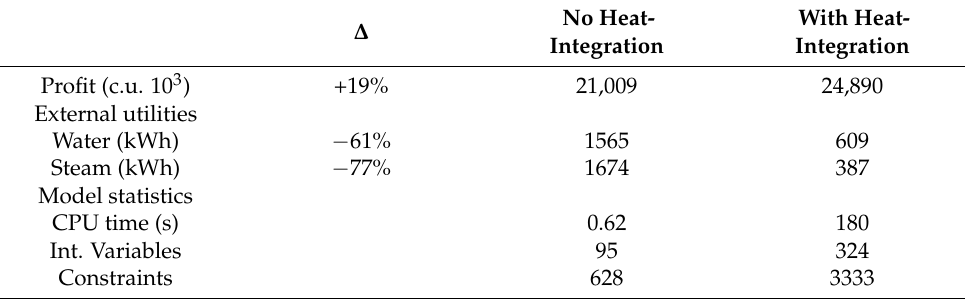
Table 9. Solutions Table 9. Solutions comparison.